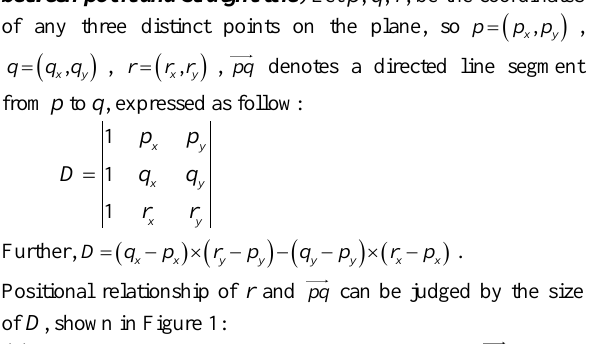
Figure 2. Judgement of the convex property or concave property of a